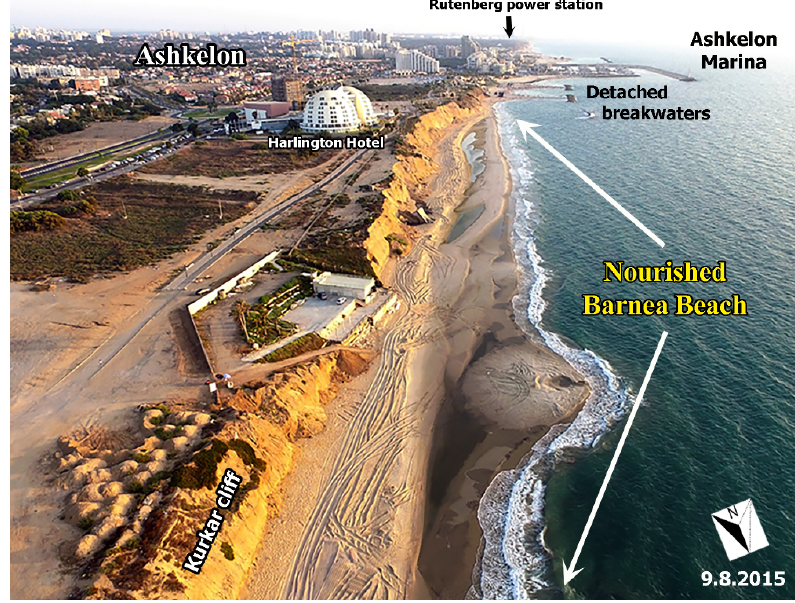
Figure 5. Aerial photograph of the coast north of Marina Ashkelon at the completion of sand nourishment (9 August 2015).